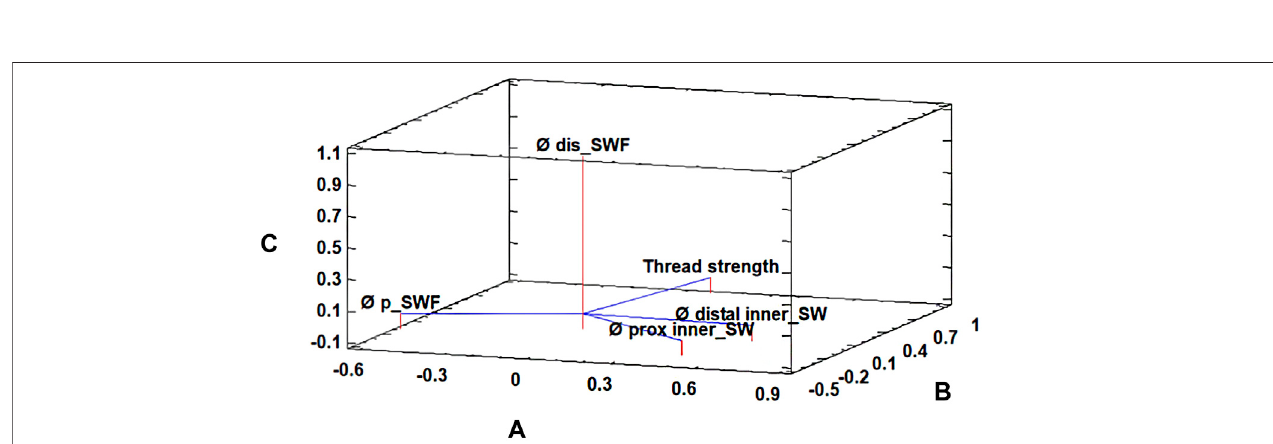
FIGURE 5 | Principal component analysis for the thread strength parameter of 8.1/6 subcategories of the radii ’ PEEK plug. The fi rst three components accounted for 51.52% (A) , 23.16% (B) , and 20.00% (C) of the total variation, respectively. Where “ Ø distal inner_SW ” is distal cavity Ø in SolidWorks (SW), “ Ø prox inner_SW ” is proximal cavity Ø in SW, “ Ø p_SWF ” is proximal cavity Ø difference between SW and FunMat, and “ Ø dis_SWF ” is distal cavity Ø difference between SW and FunMat.